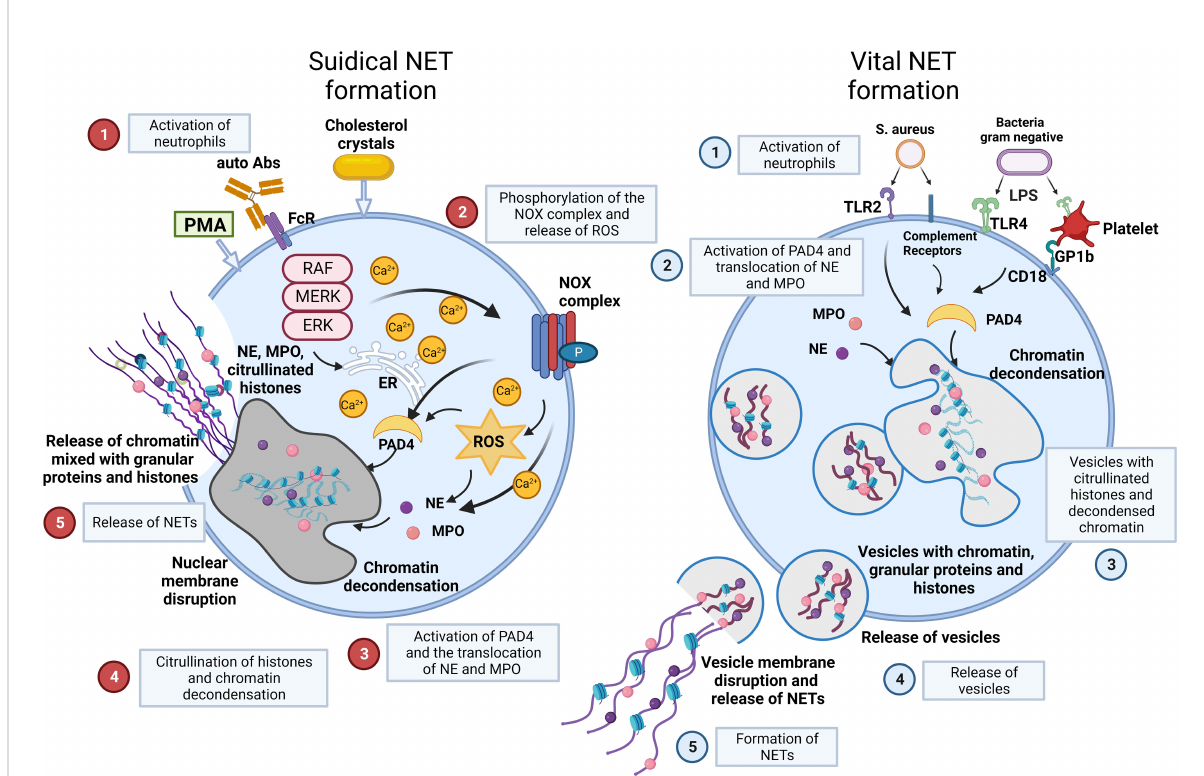
FIGURE 2 NET formation: suicidal NETosis and vital NET formation establish two main types of chromatin release by neutrophils. Suicidal NETosis is characterized by ROS generation and rupture of neutrophils. Neutrophils are activated by stimuli, such as PMA, cholesterol crystals, certain autoantibodies or immune complexes. These extracellular signals induce the phosphorylation of the NOX complex and the release of ROS. This process depends on a high Ca 2+ concentration. Subsequently, PAD4 is activated and causes the translocation of NE and MPO from azurophilic granules to the nucleus. NE and MPO combined with PAD4 result in the citrullination of histones and chromatin decondensation. After rupture of the nuclear membrane, the decondensed chromatin enters the cytoplasm mixed with granular proteins. Finally, the cytoplasma membrane gets leaky, the modi fi ed chromatin is released from neutrophils and forms NETs. In contrast, Vital NET formation is executed in a shorter time after activation of neutrophils and can also occur in the absence of the NOX complex and ROS. Vital NET formation is initiated by stimuli, such as S. aureus through TLR2 and complement receptors, or LPS from gram negative bacteria through TLR4 or indirectly through TLR4-activated platelets. PAD4 is activated and NE and MPO translocate to the nucleus to promote chromatin decondensation. The decondensed chromatin decorated with granular proteins and histones is packed in vesicles that bud from nuclei. Subsequently, these vesicles are expelled from intact neutrophils and form NETs in the vicinity of the neutrophils. In consequence, neutrophils stay intact and can exert further functions, such as phagocytosis. Figure adopted with modi fi cations from [36], with permission from Springer Nature, Nature medicine © [2017]. Abs, antibodies; FcR, Fc receptor; GP, glycoprotein; MPO, myeloperoxidase; NE, neutrophil elastase; NOX, NADPH oxidase; P, phosphorylation; PAD4, protein- arginine deiminase 4; PMA, phorbol-12-myristate-13-acetate; ROS, reactive oxygen species; S.aureus, staphylococcus aureus; TLR, toll like